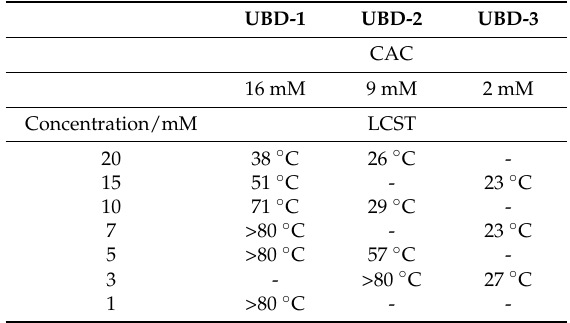
Figure 4. LCST behavior of ( a ) UBD-1 at given concentrations and ( b ) 10 mM solutions of UBD-1 – 3 . Table 1. CAC Values and Concentration Dependence of the LCST Values of UBD